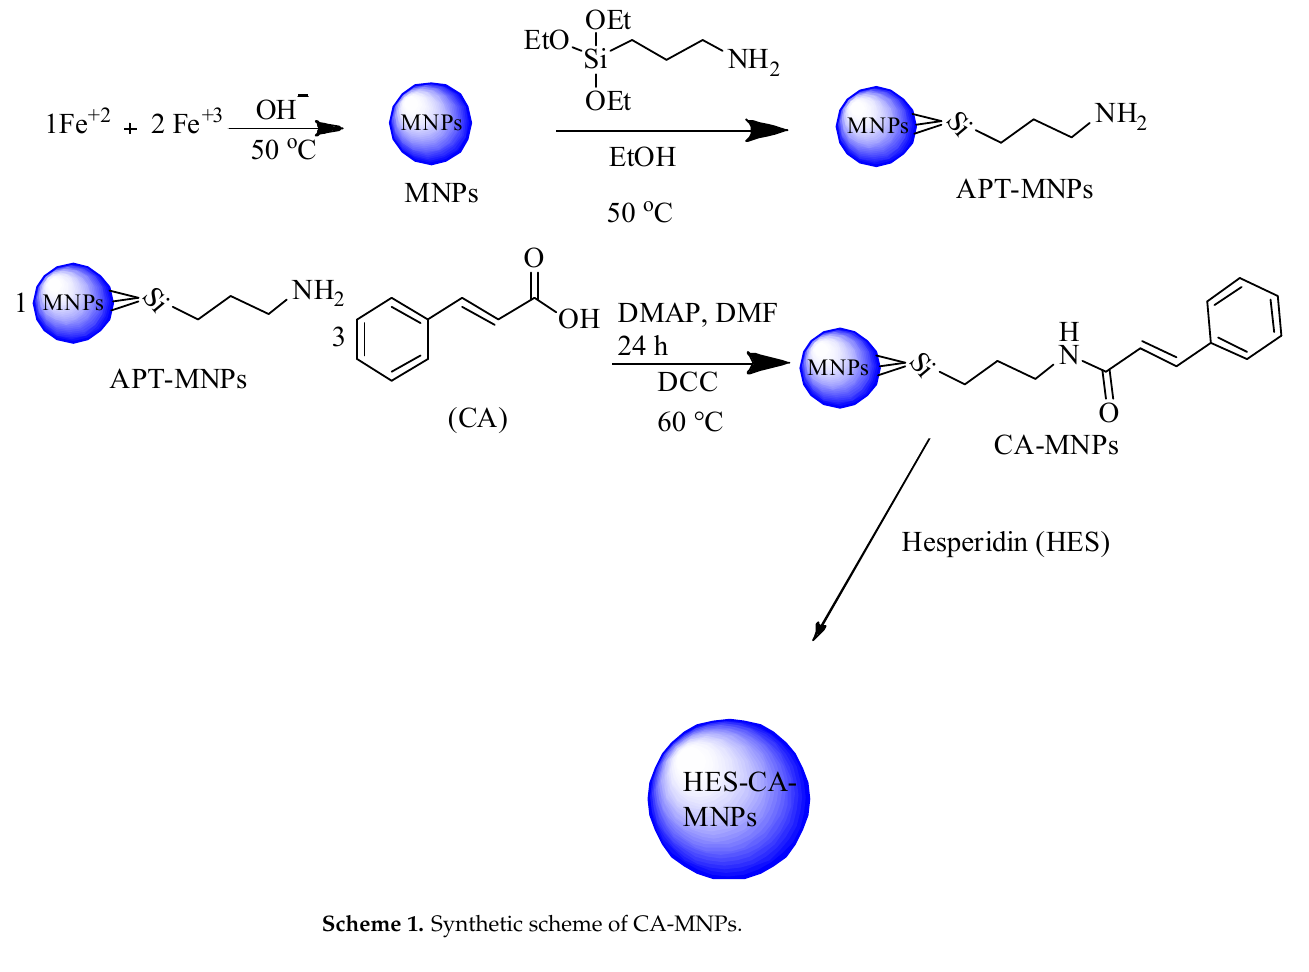
Scheme 1. Synthetic scheme of CA-MNPs.